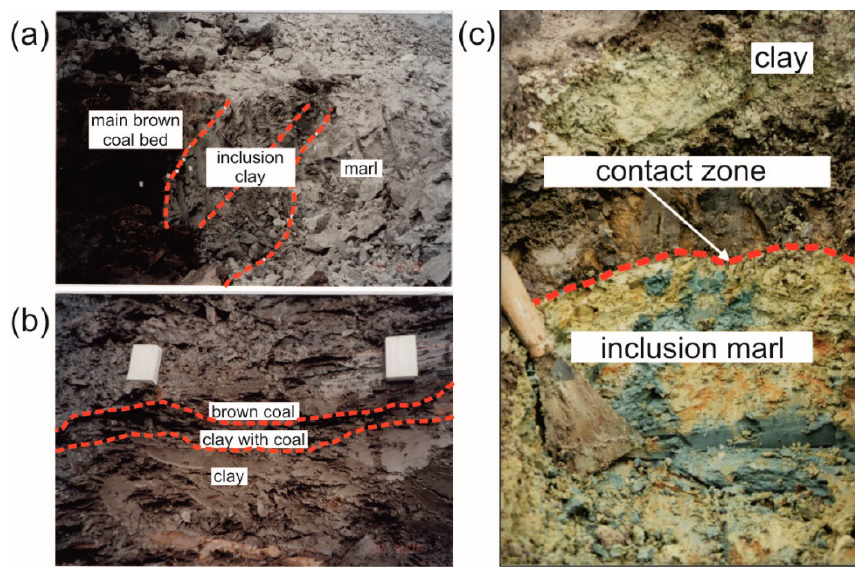
Figure 6. An example view of the complex structure and properties of the colluvium in the research area: ( a ) visible clay inclusions in the main lignite seam A; ( b ) contact zone between lignite and clay; ( c ) waterlogged contact zone between clay and marl (photo by R. Kaczmarczyk).